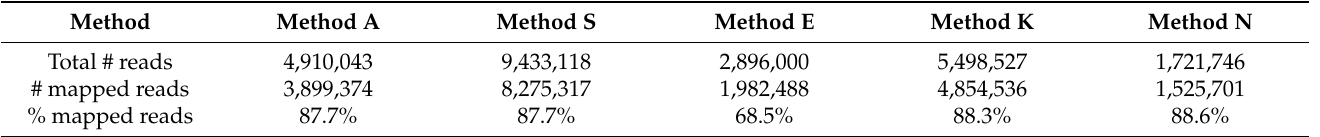
Table 3. Overall reads generated by the ONT kits evaluated. The total number of reads generated between the three RNA samples, the number of reads mapped to the H5N1 genomes, and the percentage of reads mapped to H5N1 are presented.